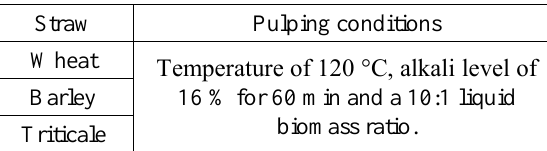
Straw Pulping conditions Wheat Temperature of 120 °C, alkali level of 16 % for 60 min and a 10:1